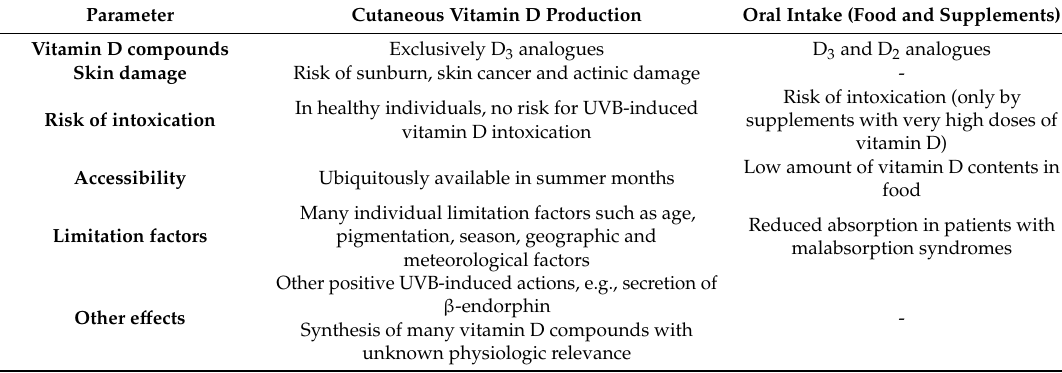
Table 4. Comparison between cutaneous Vitamin D production and oral intake (includes food and